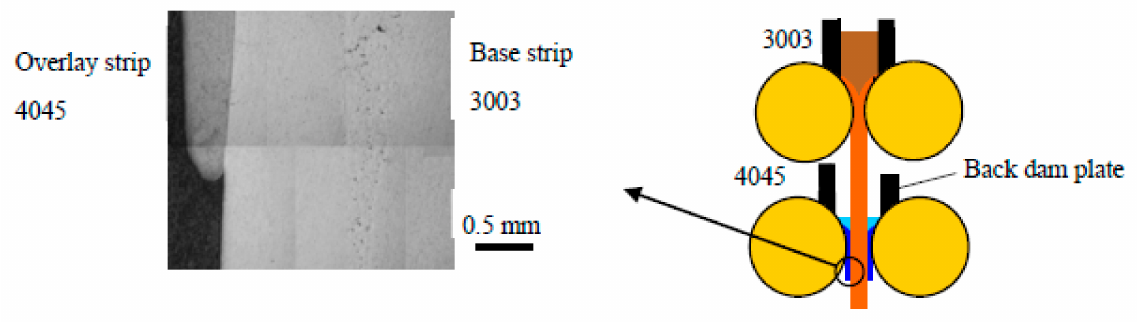
Figure 20. Starting point of cladding between the base strip and the overlay